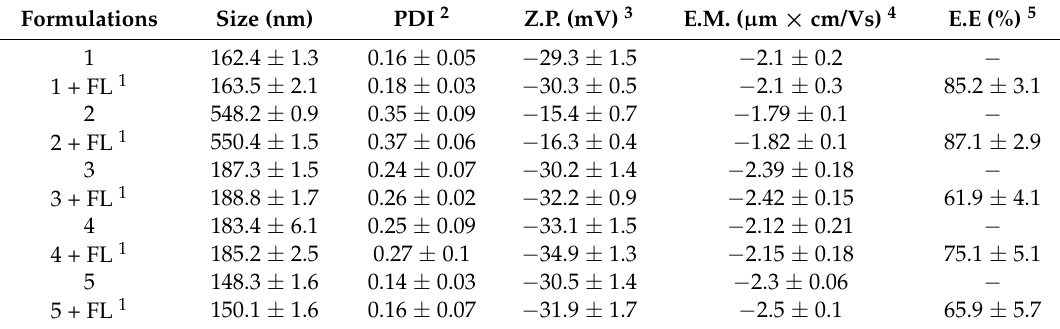
Table 2. Physicochemical characterization of lyotropic colloidal liquid